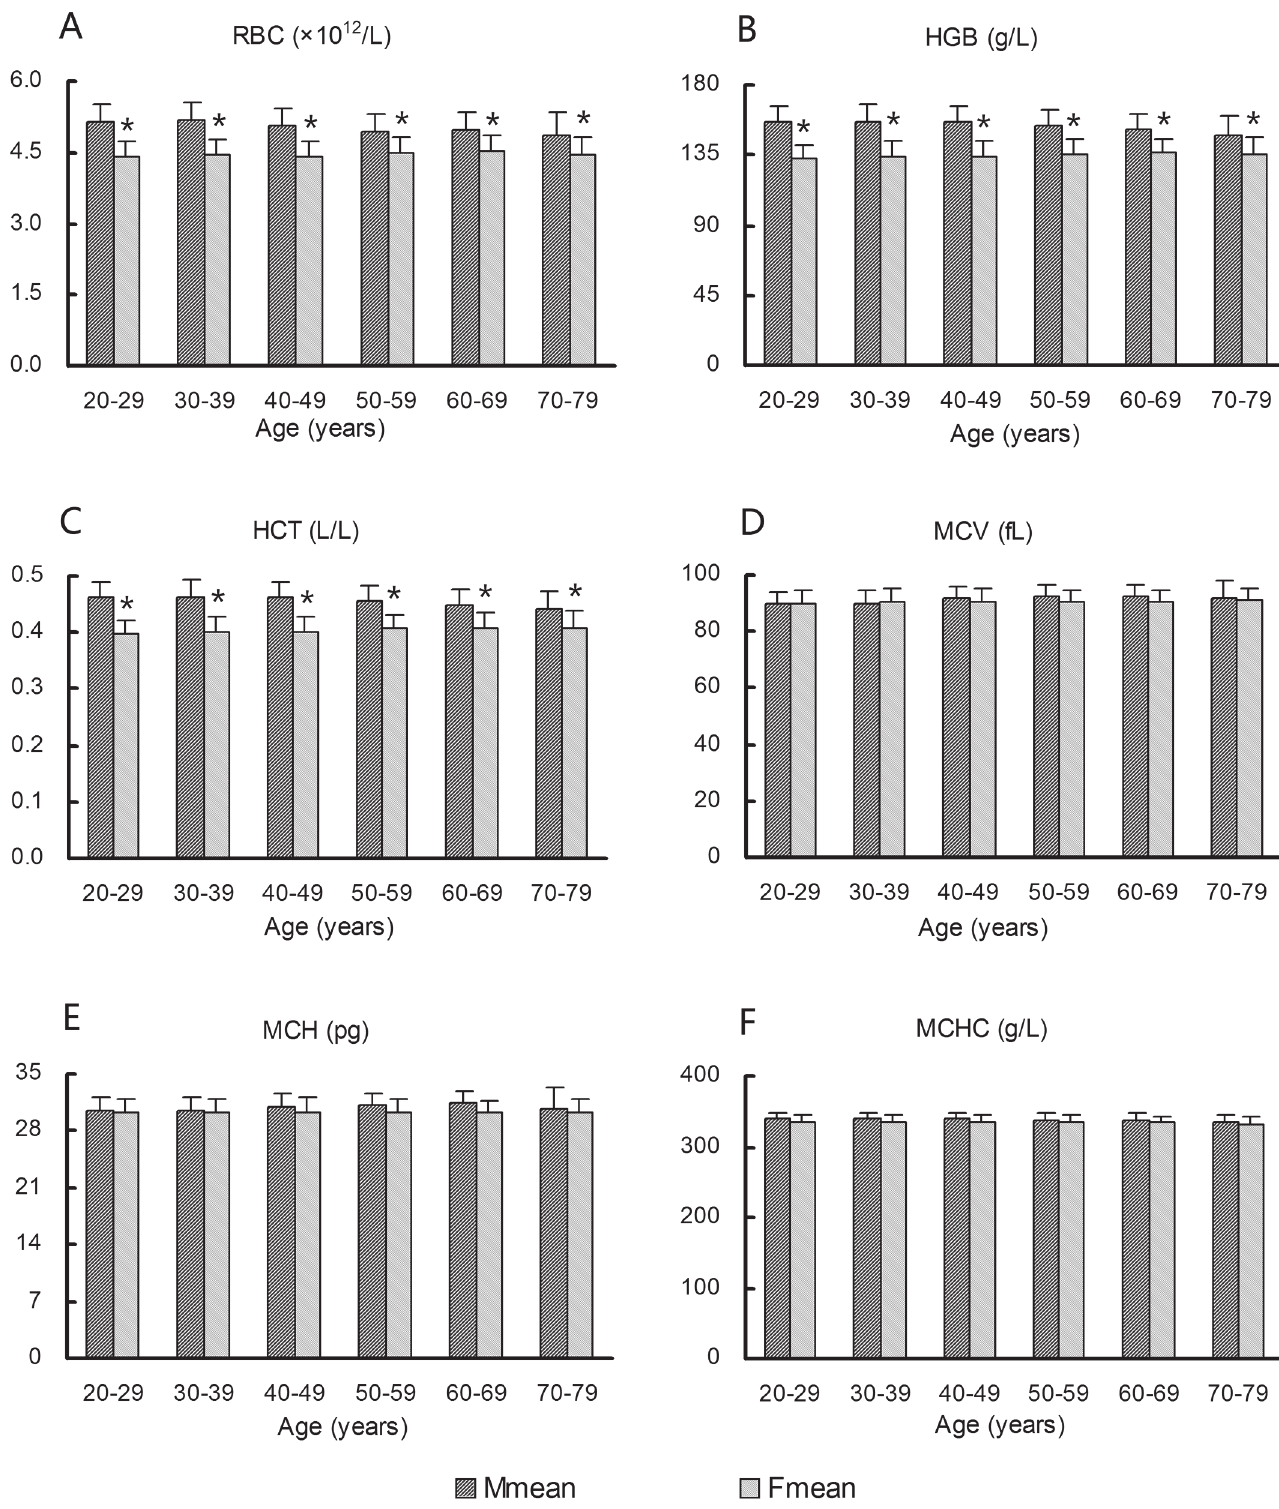
Fig 3. Variations in red blood cell (RBC) profile according to age and sex. (A) RBC, (B) hemoglobin (HGB), (C) hematocrit (HCT), (D) mean corpuscular volume (MCV), (E) mean corpuscular hemoglobin (MCH), (F) MCH concentration (MCHC). * Females show significantly lower values ( P < 0.05) than males in the same age